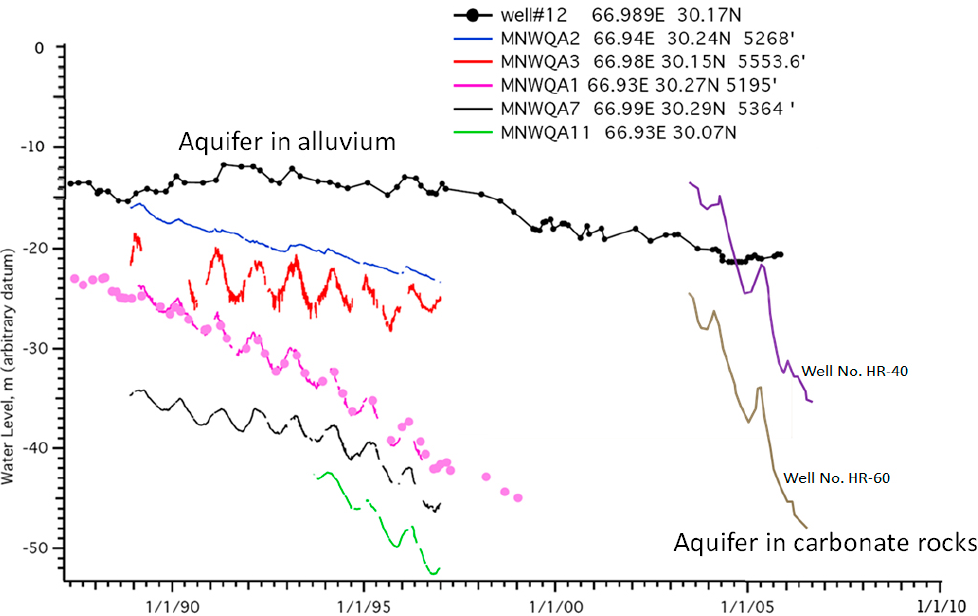
Figure 2. Water level decline from 1987–2006 in alluvial and carbonate aquifers of Quetta Valley [21]. The hydrographs of these wells clearly indicate a constant decline in their water levels. The water level decline rate was lower at ~1 m/year in alluvial aquifers and higher at ~5 m/year in carbonate aquifers. Locations of water wells in alluvium and carbonate are indicated by blue and red dots, respectively, in Figure 1.